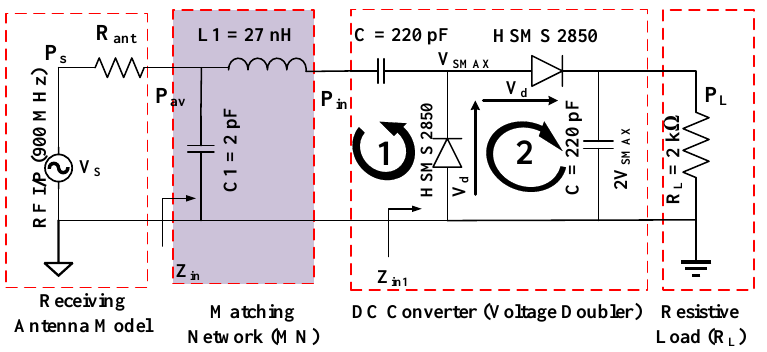
Figure 2. Detailed circuit configuration of the proposed